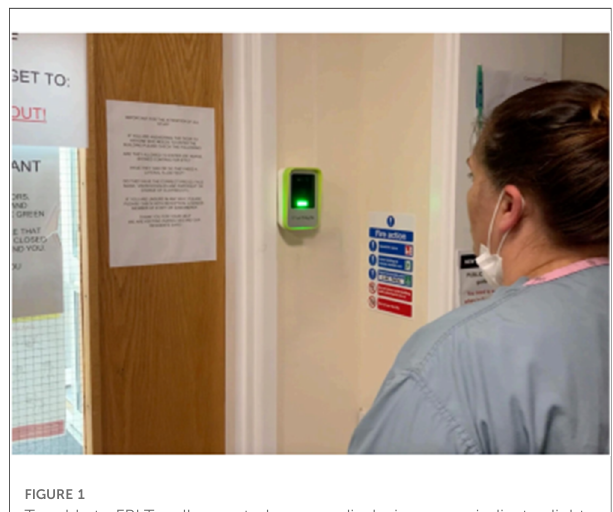
FIGURE 1 Touchbyte FRLT wall mounted camera displaying green indicator